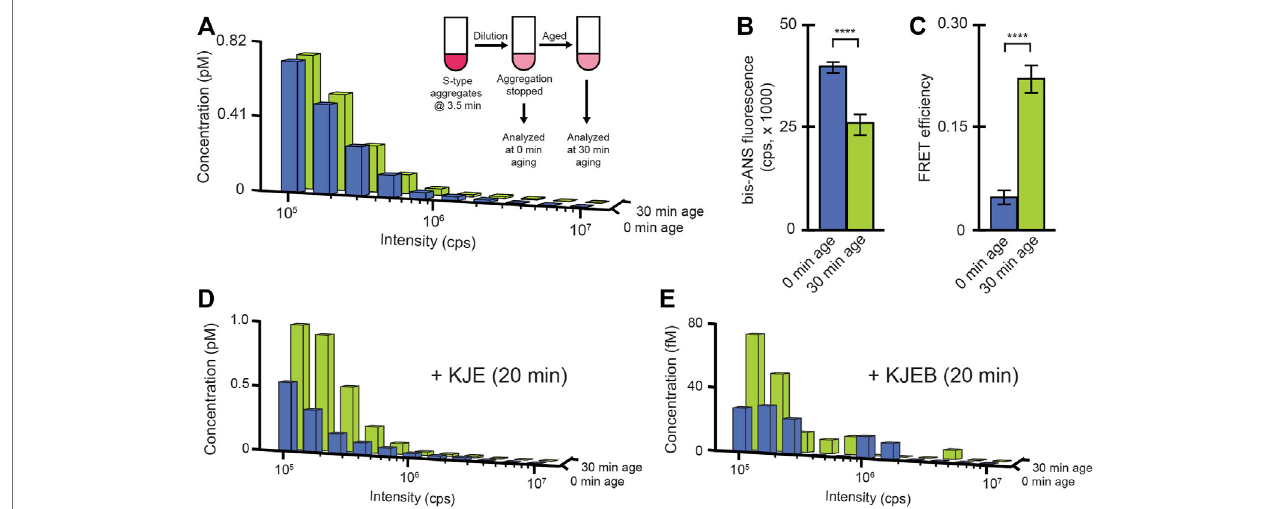
FIGURE 6 | A conformational change in S-type aggregates inhibits disassembly. (A) S-type RuBisCO-TMR aggregates were grown for 3.5 min, then diluted to a fi nal monomer concentration of 10 nM to halt growth (inset). Samples were then analyzed by BAS immediately (blue) or after a30 min incubation at 23 ° C (green). Aging- induced changes in the average conformational properties of S-type aggregates were examined by bis-ANS binding (B) and sensitized inter-molecular FRET (c; 1: 1 donor-to acceptor-labeled monomers at 1:4 total labeled to unlabeled monomers, 58F + 454ED). Error bars show the standard deviation of n = 3, independent experiments. Student ’ s t-test p -values of **** < 0.001. The impact of aging on disaggregation by the DnaK system alone (D) or the full bi-chaperone system (E) were examined by BAS following 20 min of exposure to the indicated chaperones and ATP. The BAS histograms are a combination of data from n = 3 independent